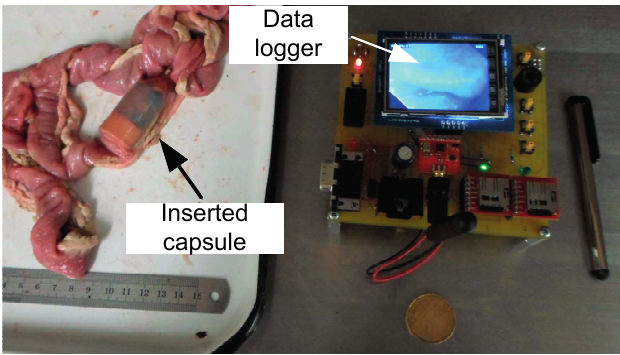
Figure 10. Experimental setup: capsule inserted in pig’s intestine and the data logger is showing real-time inside image of the intestine.